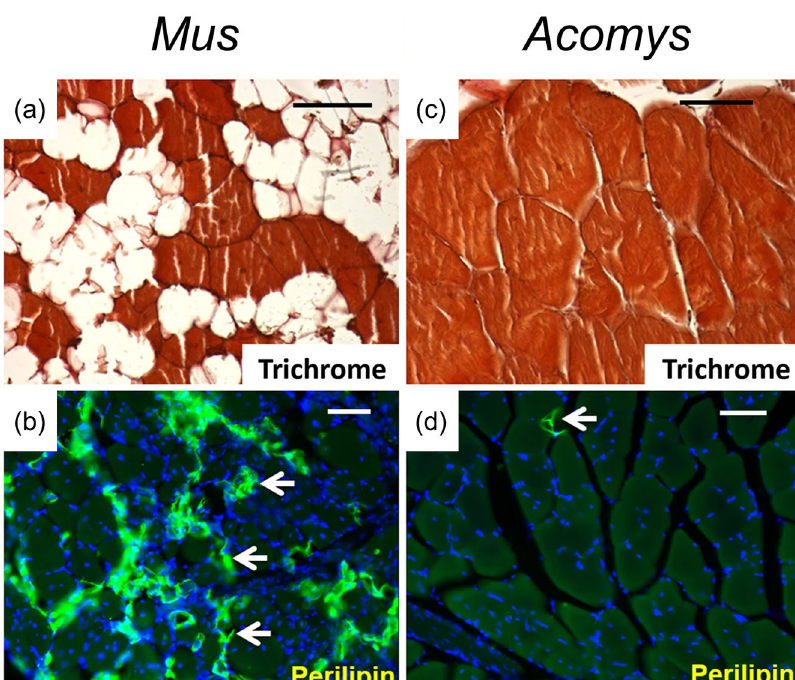
Fig. 2 Muscle regeneration in Acomys . Representative images of Mus ( a , b ) and Acomys ( c , d ) muscle after repeated injections of myotoxin. Acomys muscle regenerates perfectly and looks similar to uninjured tissue whereas in Mus , myo fi brils are replaced with adipose tissue. Accumulation of adipose tissue in Mus is re fl ected in white regions of Trichrome stain ( a , scale bar = 50 µm) and immunolabeled perilipin, a marker for adipocytes as indicated by white arrows ( b , scale bar = 100 µm). Green = perilipin, blue = nuclei. Image adapted from Maden et al. 6 under Creative Commons Attribution 4.0 International